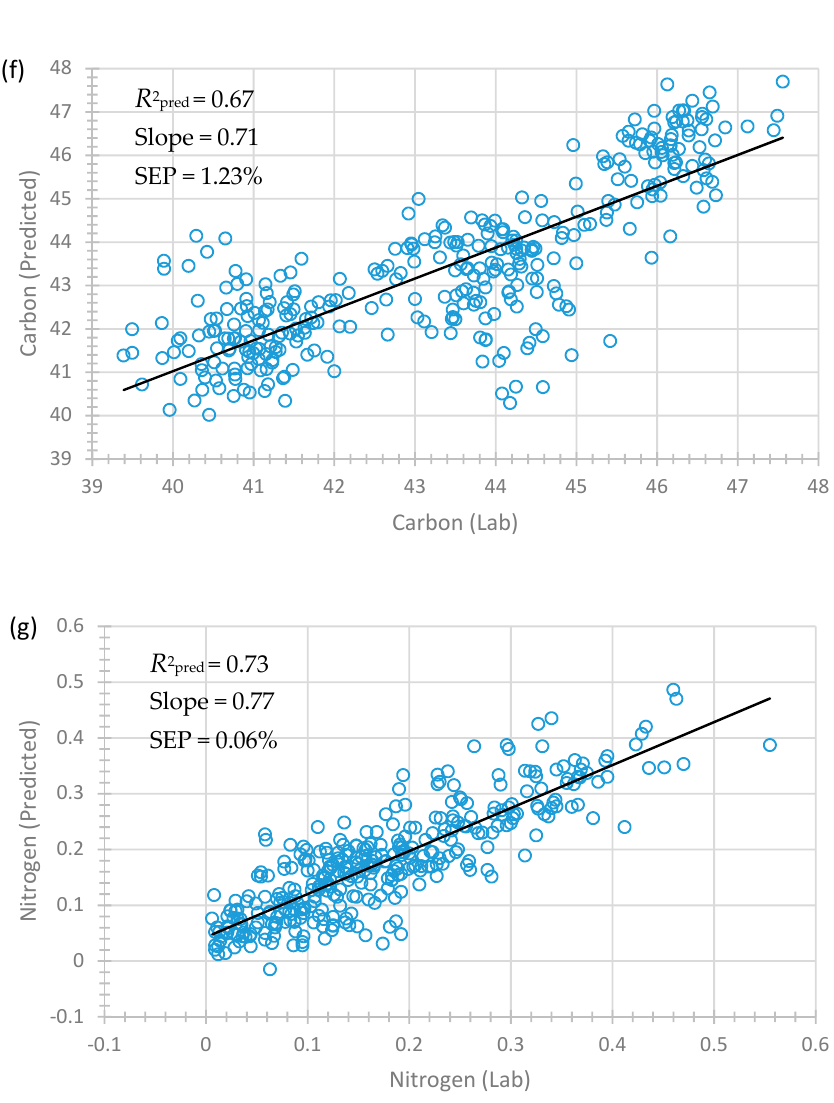
Figure 1. Linear regression relationship (includes R 2 pred , slope, and SEP) of laboratory reference data and NIRS predicted values from the first validation set for ( a ) neutral detergent fiber (NDF), ( b ) acid detergent fiber (ADF), ( c ) acid detergent lignin (ADL), ( d ) cellulose, ( e ) hemicellulose, ( f ) carbon, and ( g ) nitrogen using the broad NIRS models developed when combining a population of 480 cultivars in four environments. Table 3. Coe ffi cients of Pearson Correlation between laboratory reference data and NIRS predicted values for NDF, ADF, ADL, cellulose, hemicellulose, C, and N in the first validation set. NDF ADF ADL CELL HEMI C N Correlation 0.92 0.93 0.81 0.94 0.65 0.82